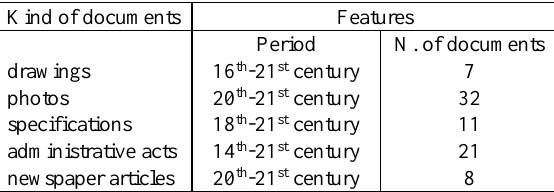
Table 8. Historical documents inherent the studied area; kind, year, and number are reported